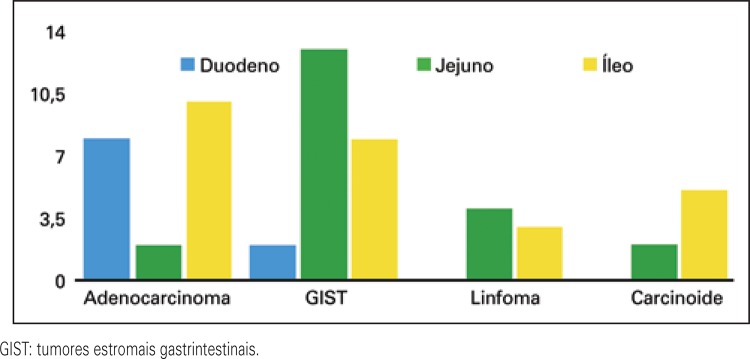
Histopatologia do tumor correlacionada à localização